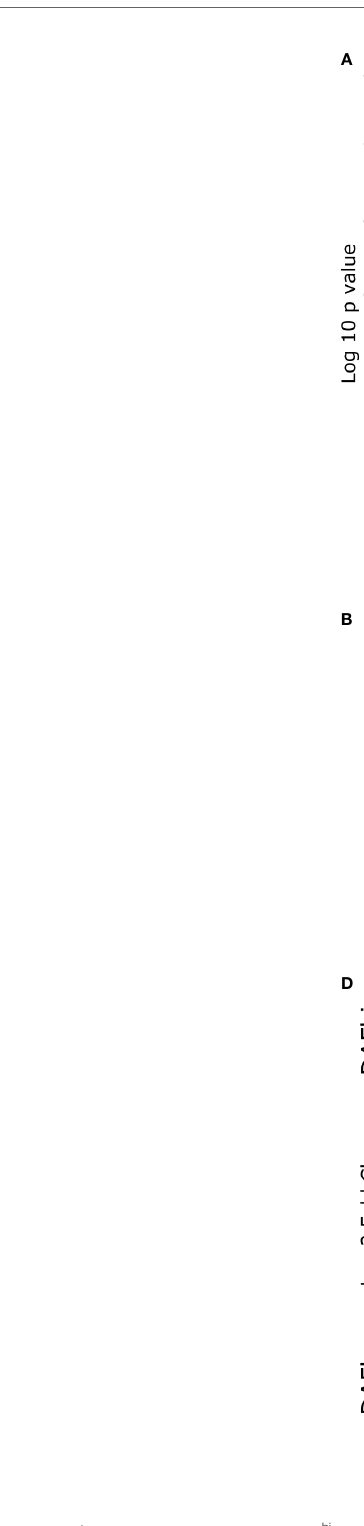
FIGURE 3 | Transcriptomic analysis of DAF hi and DAF lo germinal center B cells. (A) Volcano plot showing differences in genes expressed by DAF hi and DAF lo GC B cells. (B) Delta CT of CD55 gene expression, normalized to ACTB . (C) Flow cytometric analysis of Blimp1 expression on DAF hi , DAF lo GC B cells, and plasma cells (PC) (N = 6). (D) Clustering of DAF hi and DAF lo GC B cells in combination with transcriptomic data from sorted light zone (LZ) and dark zone (DZ) GC B cells. LZ and DZ data were obtained from Victora et al.